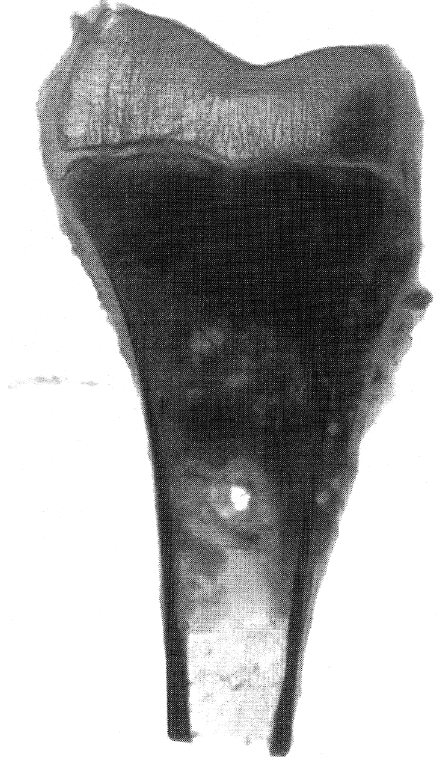
Fig. 1. Digitalised X-ray image of a 4-mm slice through the proximal tibia showing the osteosarcoma